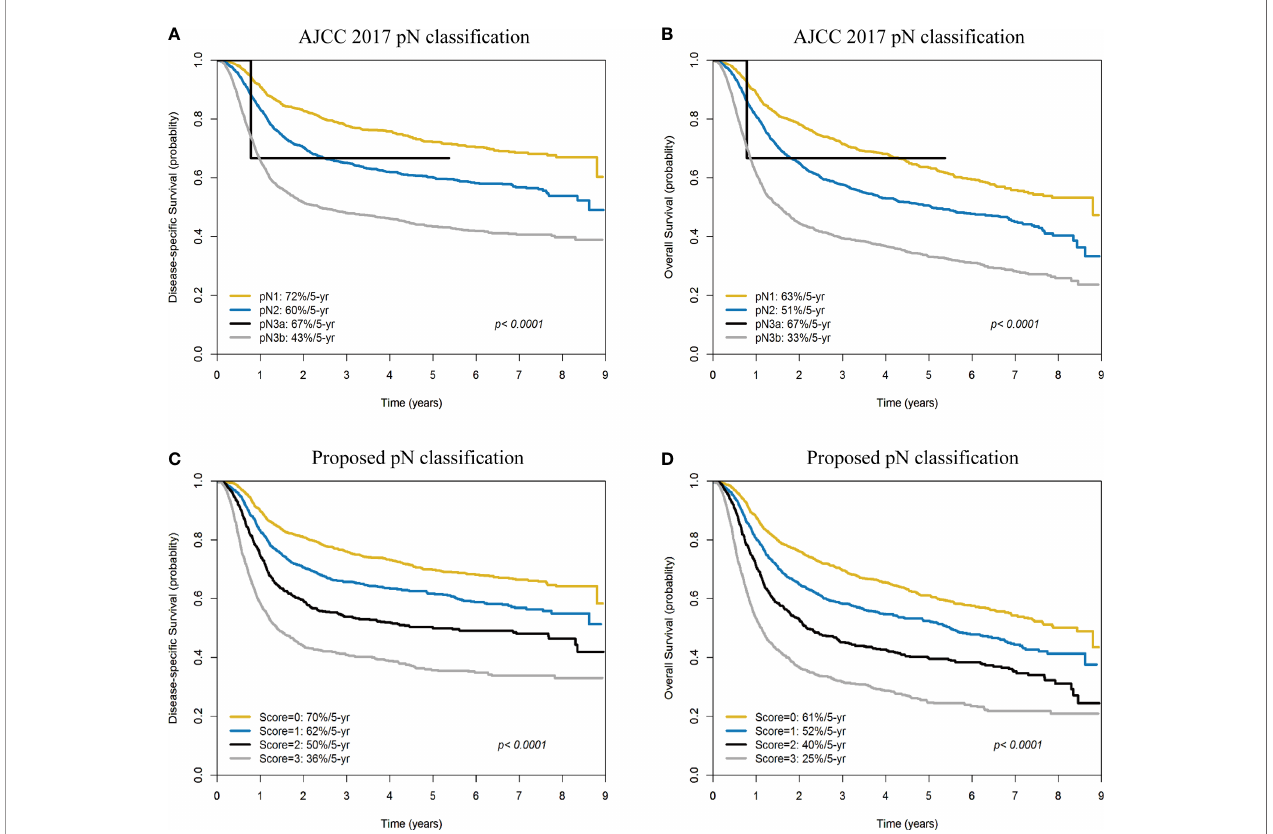
FIGURE 4 | Kaplan-Meier plots of 5-year disease-speci fi c survival (A) and overall survival (B) according to the AJCC pN classi fi cation (pN1, pN2, pN3a, and pN3b). Kaplan-Meier plots of 5-year disease-speci fi c survival (C) and overall survival (D) according to the scoring system devised in our study (scores: 0, 1, 2, and 3).